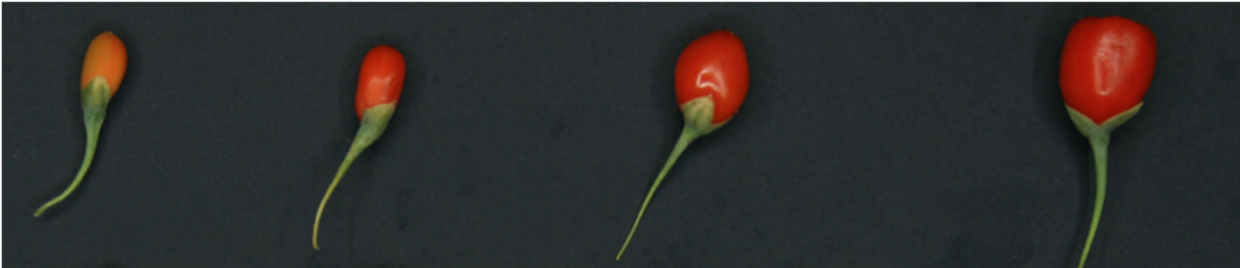
Figure 1. Four maturity stages of goji berry (Stage 1 to 4 from left to